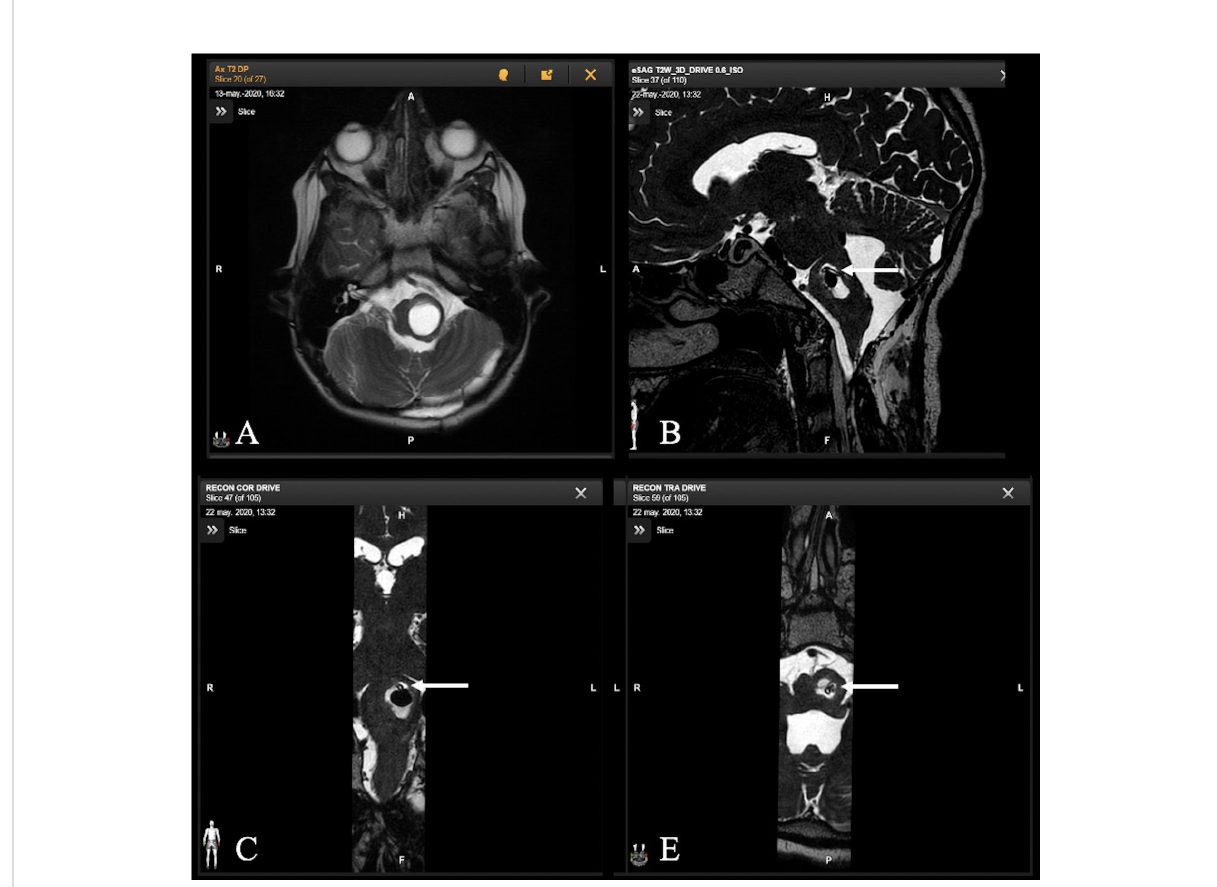
FIGURE 5 Axial T2-weighted MR image of a 13-year-old child with a focal brainstem tumor and a large cyst (A) . Acquisition of intraoperative MR images as fi nal controls with sagittal, axial, and coronal T2-weighted images shows correct placement of the catheter, indicated by the white arrow, within the tumor cyst component (B – D)